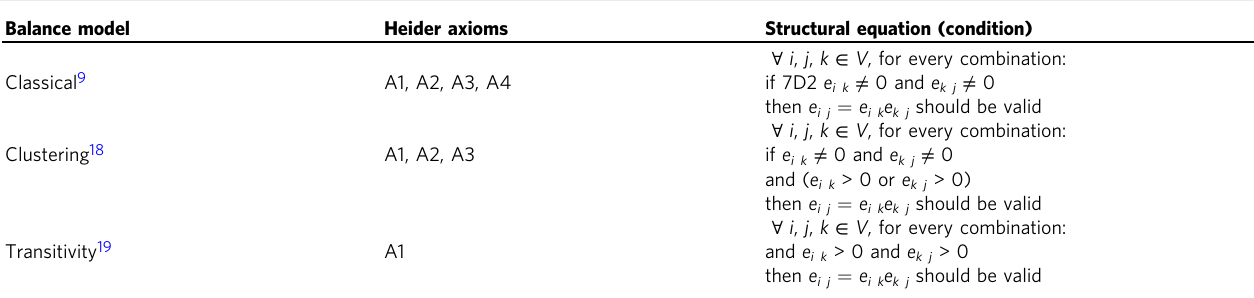
Table 1 Sparse balance theory conditions: de fi nitions of sparse structural balance theory that generalize existing de fi nitions of balance.